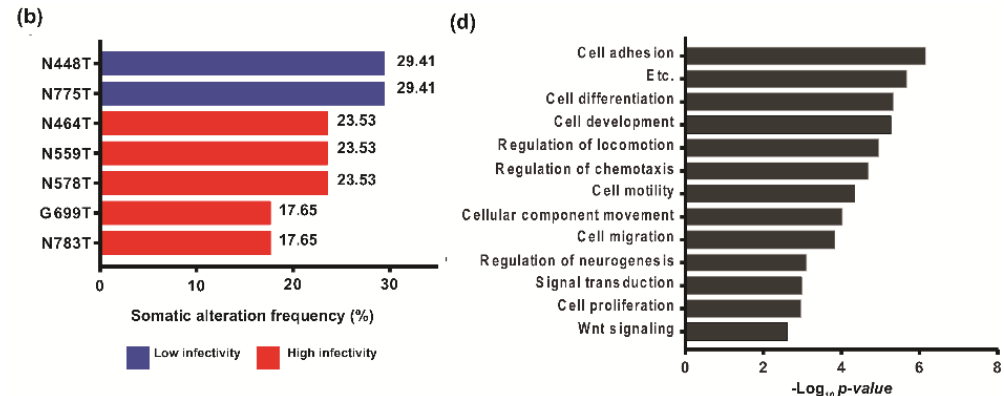
Figure 5. Analysis of host factors that inhibit infection with the sp-RRV system vector carrying TK and CD genes in patient-derived GSCs. ( a ) Summary of DNA sequencing results from tumors of seven patients with glioblastoma. Somatic mutational landscape of seven patient-derived GSCs, including single-nucleotide variants (SNVs), small insertions/deletions, and copy number alterations revealed by targeted-panel sequencing via GliomaSCAN ™ . Mutations are colored by the type of alteration, as indicated in the legend. ( b ) Somatic mutation frequency was calculated as the mutation frequency of 17 most frequently occurring genes. The bars of each row represent the frequency of SNVs and copy-number variation events found in each patient. ( c ) Schematic representation of host factors that inhibit infection with the sp-RRV system in seven patient-derived GSCs, as determined by differentially expressed gene (DEG) analysis of whole transcriptome sequencing (WTS). ( d ) Gene ontology (GO) was analyzed using the Database for Annotation, Visualization, and Integrated Discovery (DAVID); Bioinformatic Resources 6.8 was used to analyze the top 60 leading-edge genes identified by DEG analysis.